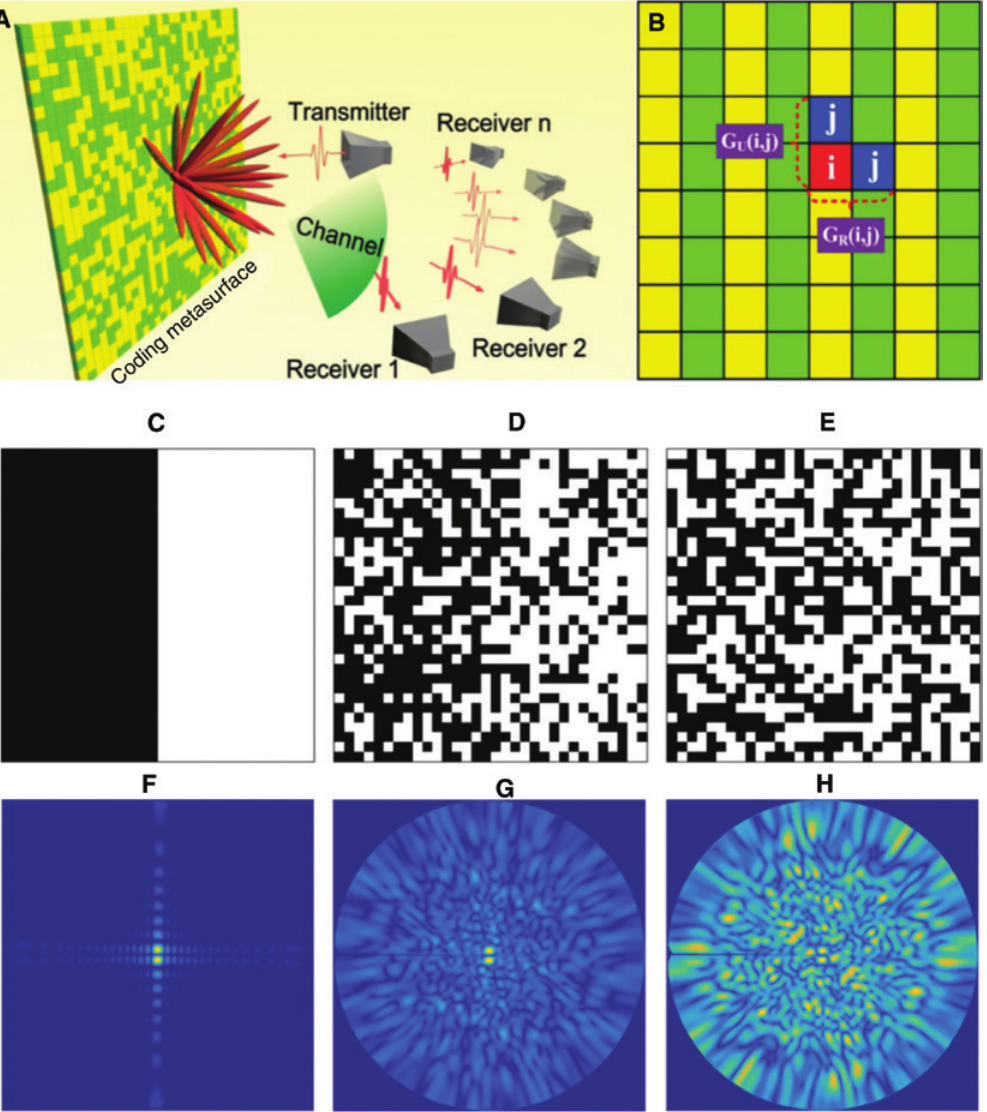
Figure 6: An information system using a reflection-type information metasurface. (B) Group G( i,j ) in a coding pattern. GR( i,j ) and GU( i,j ) are considered from the row and column, respectively. (C)–(E) Three coding patterns with increasing randomness. (F)–(H) The calculated scattering patterns at 10 GHz. It can be seen that there will be more scatterings as the coding pattern becomes more random, leading to a larger physical entropy. Adapted from